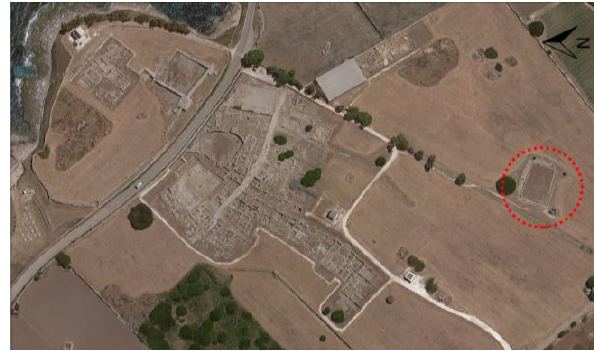
Figure 3. Aerial overview of the archaeological site of Egnatia